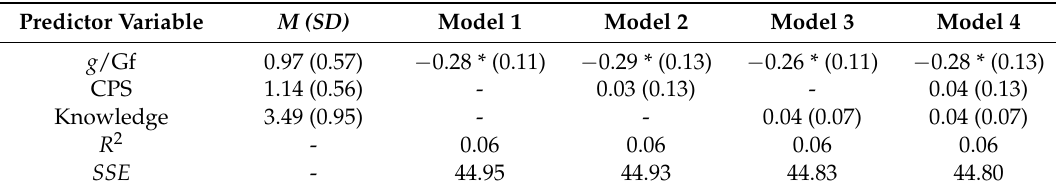
Table 7. Regression models for Job Zone 5 (DV: natural log median annual wages,